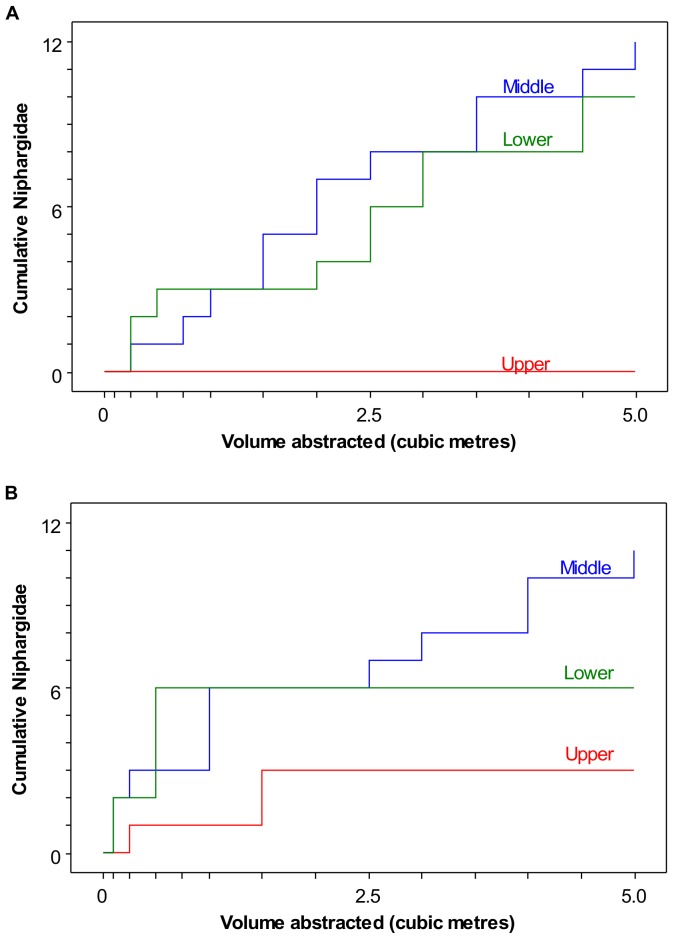
Cumulative Niphargidae captured with volume abstracted from each interval (A) BPW (B) TFM.